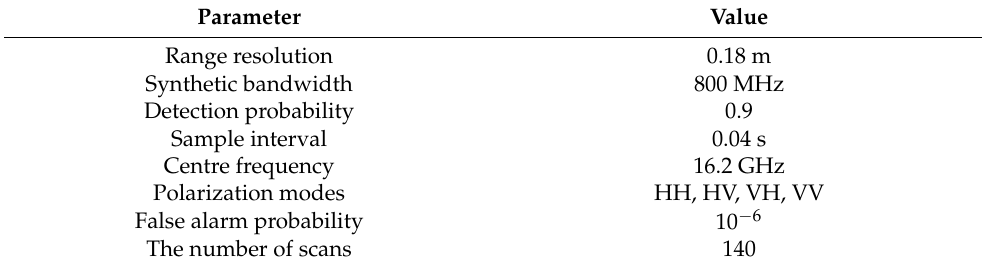
Table 6. The basic parameters of the radar system. Figure 11. Experimental scene.